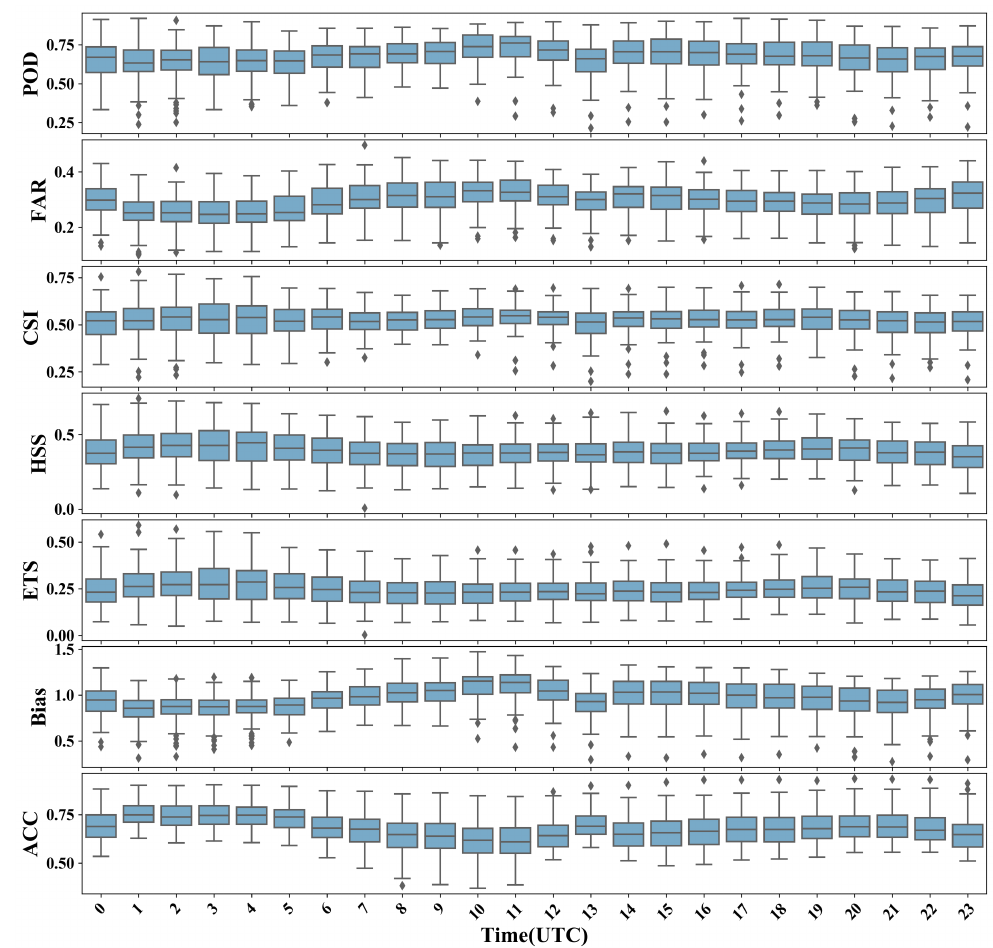
Figure 20. The diurnal variation of evaluation scores for rain area determination and precipitation grades estimation on RF model against gauge stations during summer 2019, distributions of statistical values at one hour intervals are interpreted in box plots. Box diagrams indicate the 25th, 50th, and 75th percentiles whereas the periphery of the box extends to 1.5 times of the quartile deviation (25th–75th percentile). Outliers are indicated by black